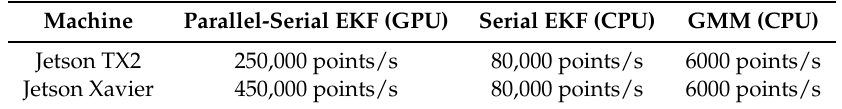
Table 3. Performance of our parallel-serial EKF algorithm in comparison with the serial EKF approach and reference method serial implementation (GMM).